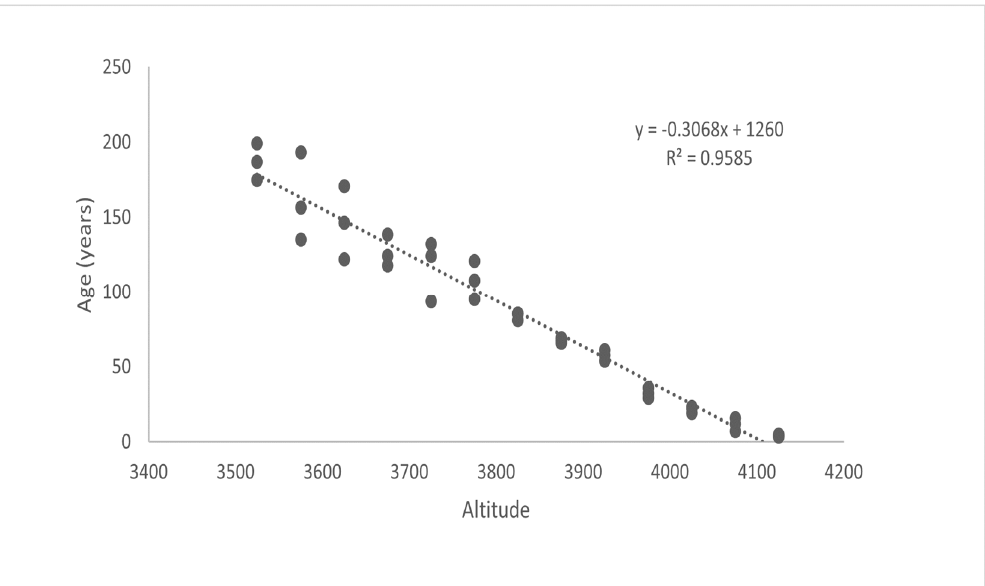
Figure 10. Average height (cm) ( a ) and Average DBH (cm) ( b ) of Juniperus macropoda along different altitudinal gradients in Lahaul Valley of Himachal Pradesh. The error bar signifies the standard deviation.